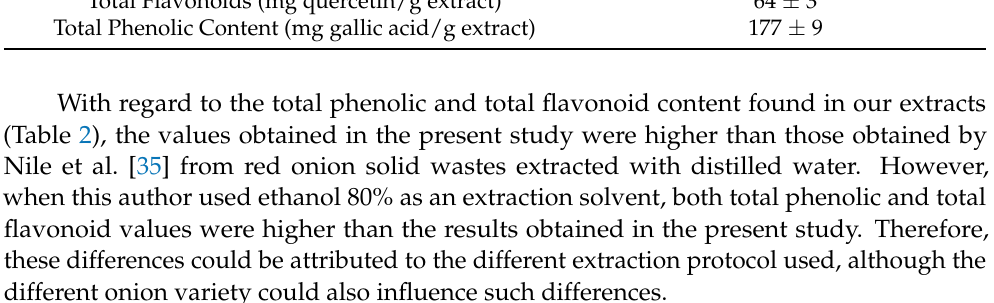
Table 2. Antioxidant capacity and total phenolic and flavonoid content of the extracts obtained from onion household wastes. Assays Concentration Antioxidant capacity by ABTS (mmol Trolox/g extract) 1.11 ± 0.08 Antioxidant capacity by FRAP (mmol Trolox/g extract) 0.83 ± 0.01 Antioxidant capacity by DPPH (mmol Trolox/g extract) 0.49 ± 0.08 Total Flavonoids (mg quercetin/g extract) 64 ± 3 Total Phenolic Content (mg gallic acid/g extract) 177 ±